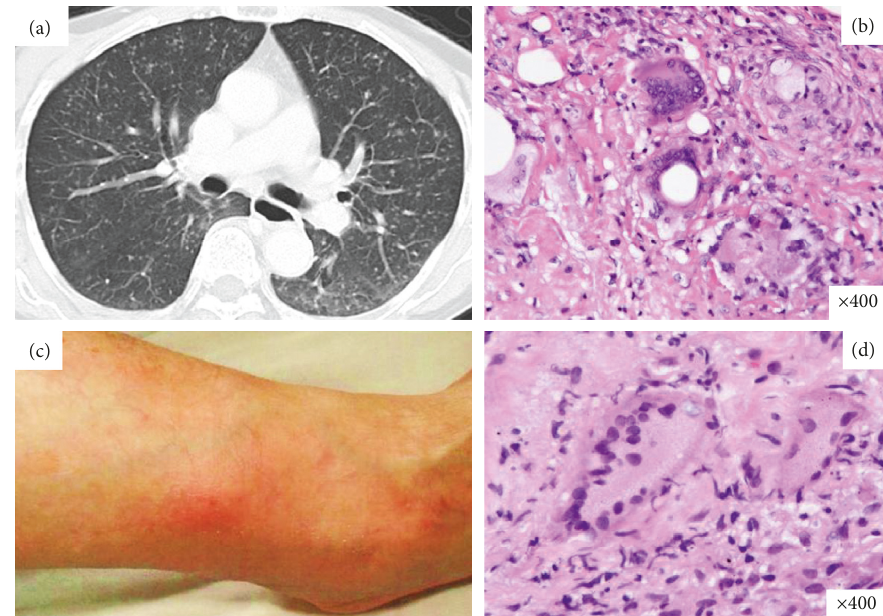
Figure 4: (a) Chest CTscan image at the time of admission. Diffuse particulate shadows are shown in the whole-lung field at random; (b) noncaseating epithelioid granuloma was observed in bronchial and alveolar specimens obtained through bronchoscopy (hematoxylin and eosin (H & E) stain; magnification x400); (c) a cellulitis-like lesion on the patient’s right lower limb; (d) biopsy specimens from cellulitis also revealed erythema induratum of Bazin (H & E stain; magnification x400) (case